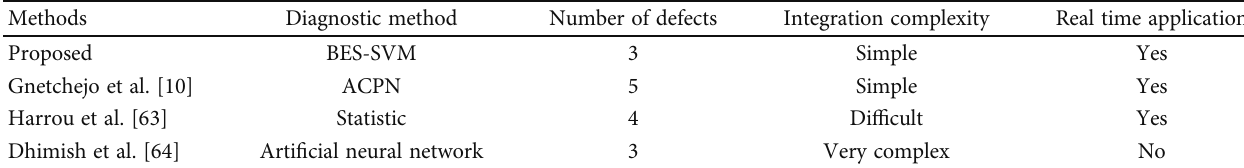
Table 5: Comparison of the di ff erent